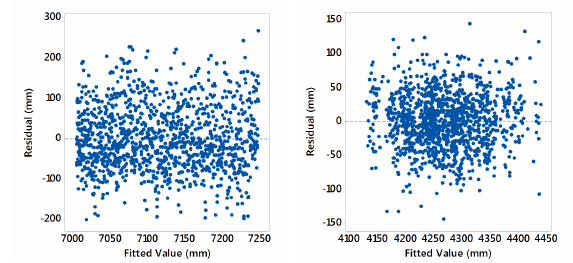
Figure 4: Plot of the residuals against the fitted (adjusted) observa- tions for the baseline model solution (left) and the new kinematic model solution. Note that the residuals and the fitted values refer to the white noise assumption for the baseline model solution. The new model autocorrelated errors were calculated using fitted values based on the transformed model h t − ^ ρ h t −1 (Hidreth and Lu, 1960) where ^ ρ = 0.3